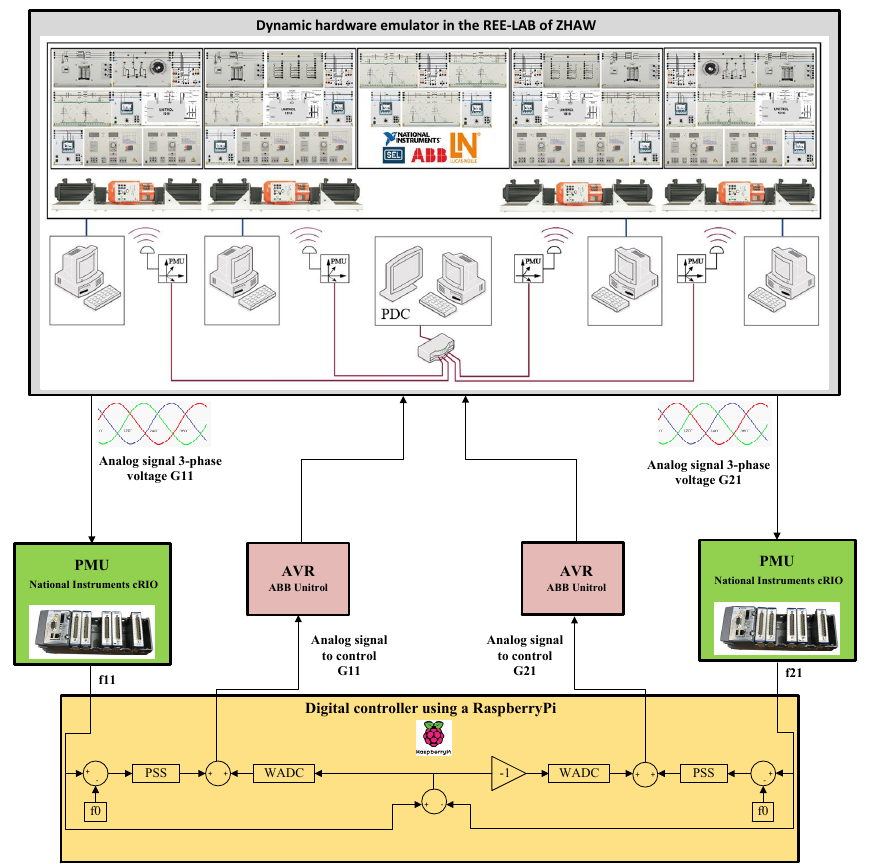
Figure 16. Schematic drawing of the dynamic hardware emulator setup including the PMUs, the digital controller and the ABB Unitrol.